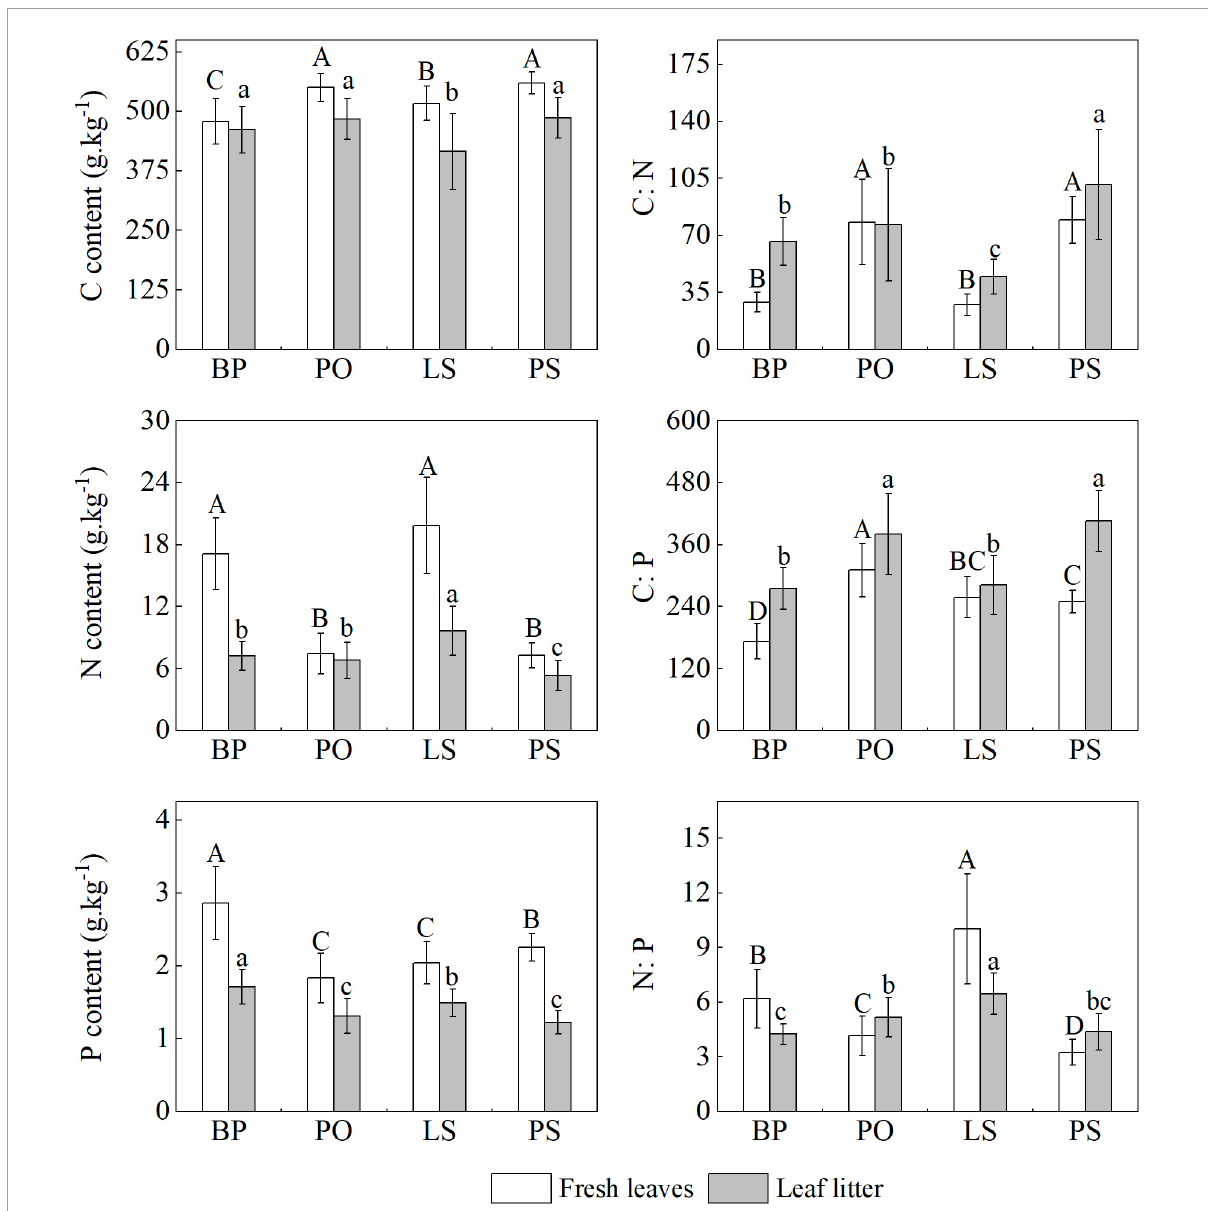
FIGURE2 Leaf C, N, and P concentrations and stoichiometry of four tree species. Betula pendula (BP), Picea obovata (PO), Larix sibirica (LS), and Pinus sibirica (PS). Different lowercase letters represent significant differences in fresh leaves of different tree species ( p < 0.05). Different capital letters represent significant differences in leaf litters of different tree species ( p <